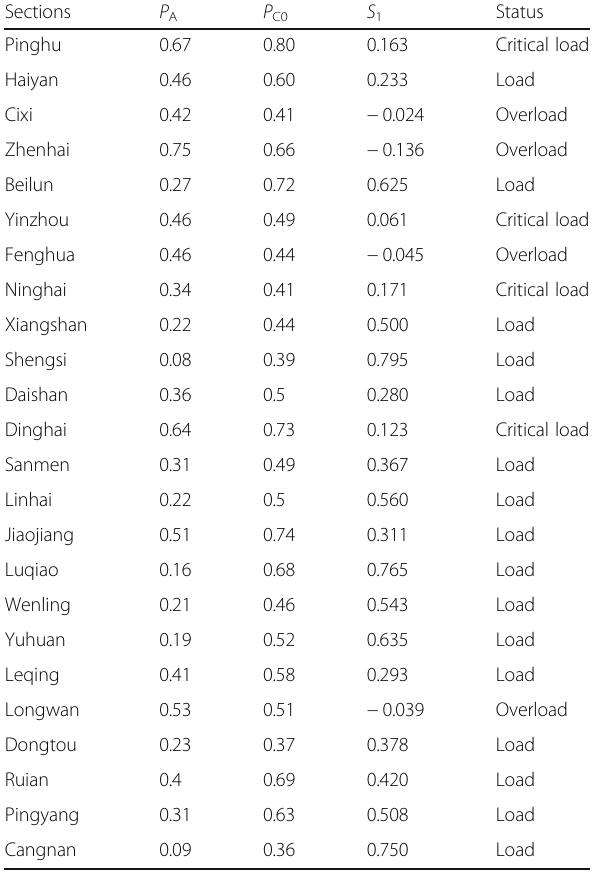
Table 8 Evaluation of exploitation of Jiangshu coastline